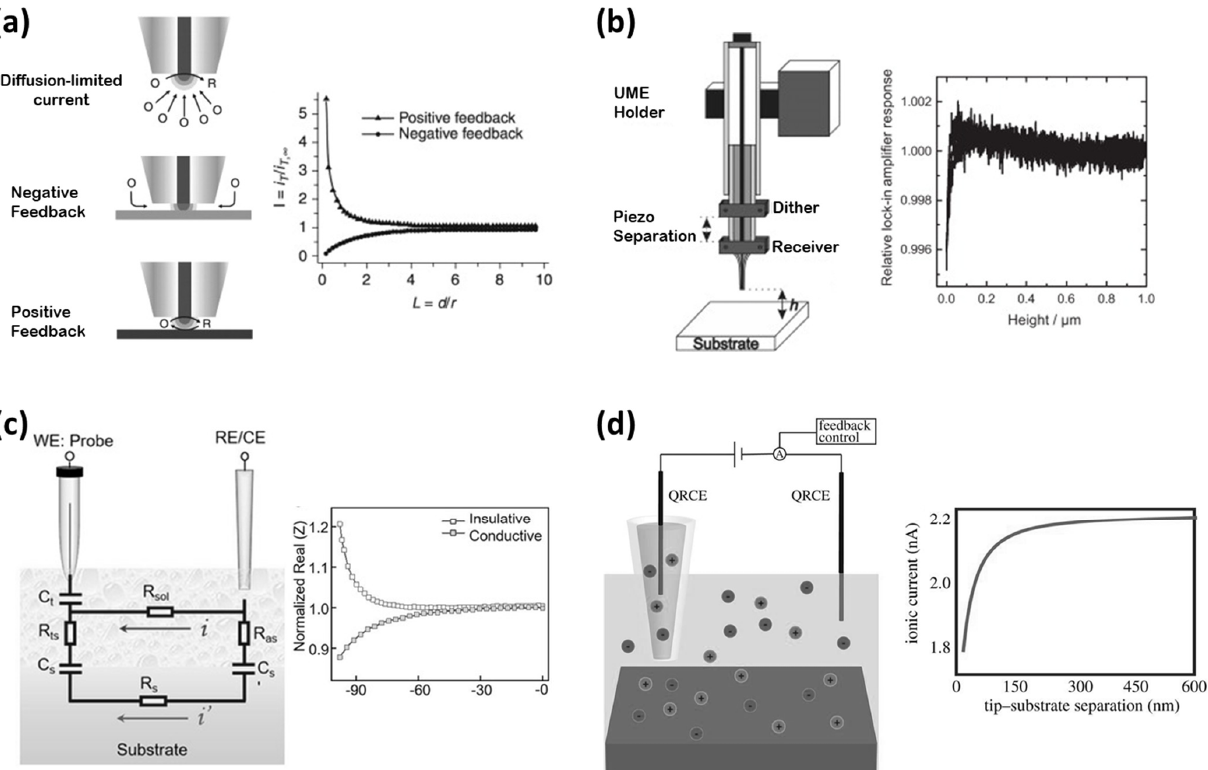
Figure 5. Probe-positioning methods for pH sensors and examples of their approach curves. ( a ) Hemispherical diffusion-limited current and pure feedback cases of scanning electrochemical microscopy. Adapted from ref. [74]. Copyright (2012) with permission from Elsevier. ( b ) Shear force sensing in the two piezo dither/receiver arrangement. Adapted from refs. [75,76]. Copyright (2013) and Copyright (2014) with permission from Elsevier. ( c ) Alternating current-scanning electrochemical microscopy and the equivalent circuit for the overall impedance response. Adapted from ref. [77]. Copyright (2019) with permission from John Wiley and Sons. ( d ) Representation of the operation principle of the scanning ion-conductance microscopy. Adapted from ref. [78]. Copy- right (2017) with permission from The Royal Society.